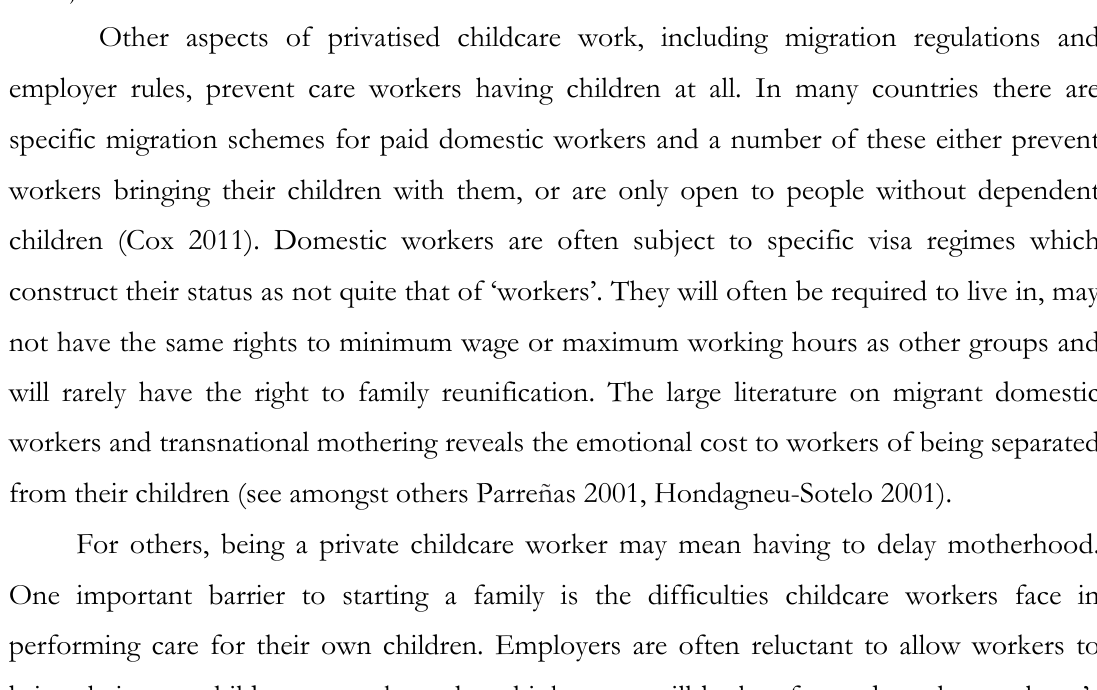
Rosie Cox: Competitive Mothering and Delegated Care: Class Relationships in Nanny and Au Pair